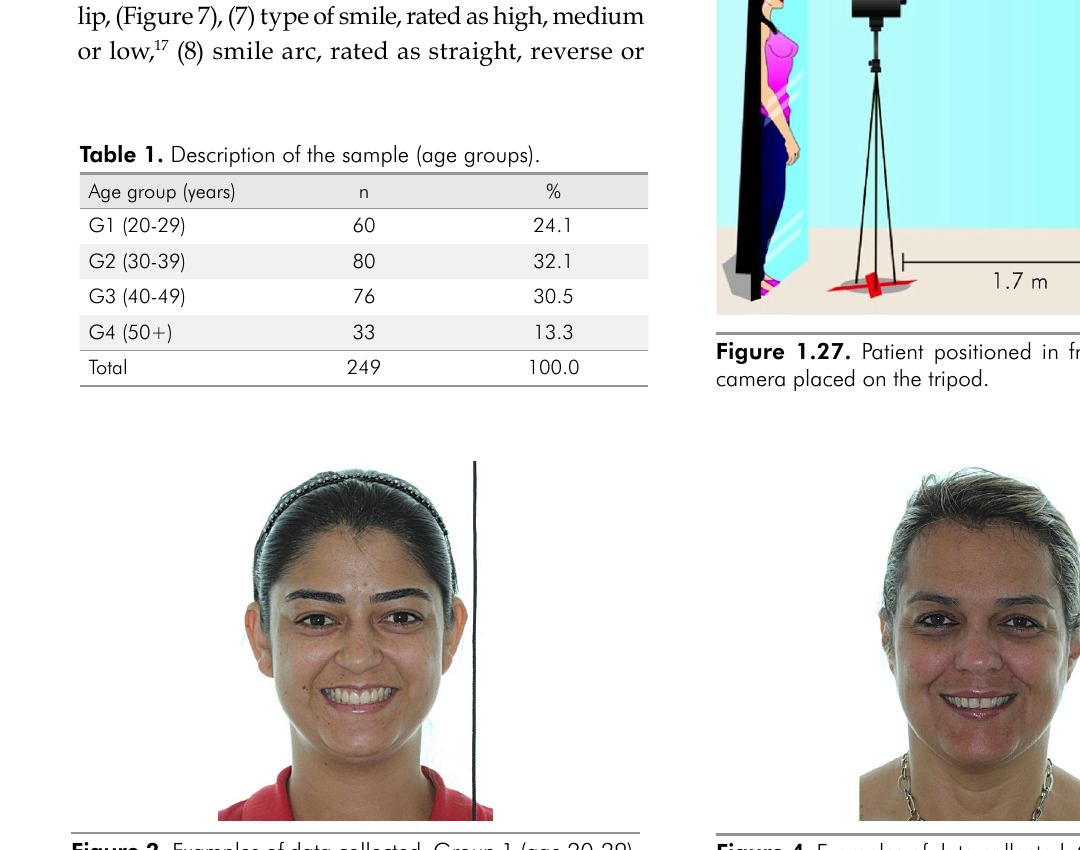
Figure 4. Examples of data collected. Group 3 (age 40-49).